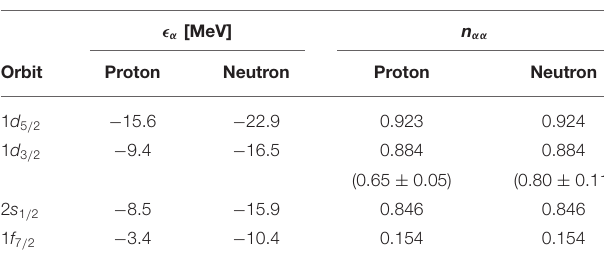
TABLE 1 | Single-particle energies ǫ α and occupation probabilities n αα calculated in TDDM for 40